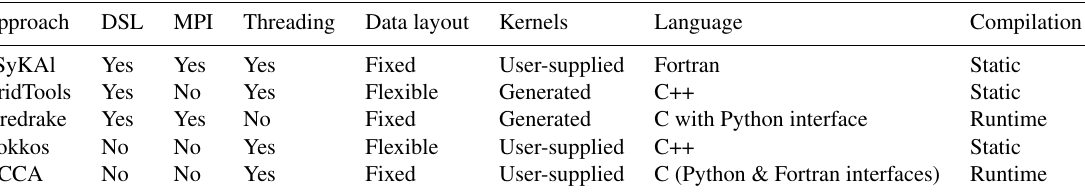
Table 1. An overview of the functionality of similar approaches. Static compilation here means that all code is compiled before programme execution is begun.